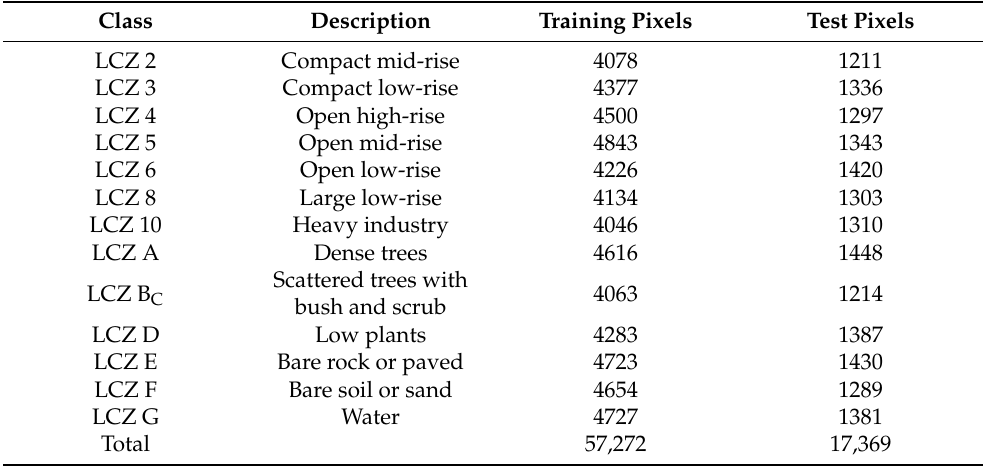
Table 2. Description of LCZ classes and the number of training and test pixels in the